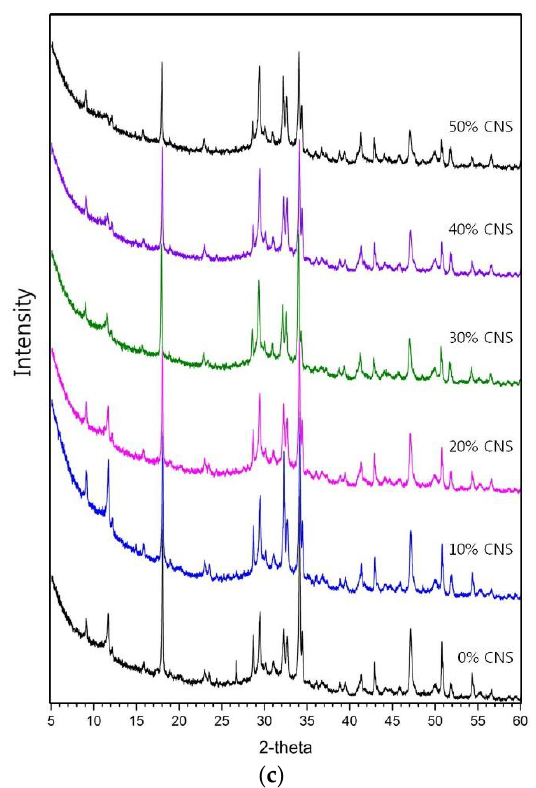
Figure 5. XRD results after 1-day and 28-day: ( a ) 0% CNS, ( b ) 50% CNS, ( c ) compared XRD with CNS, P: portlandite, E: ettringite, G: gypsum, C: calcite, M: magnesium oxide, S: quartz, A: alite, B: belite, CSH: calcium silicate hydrate.